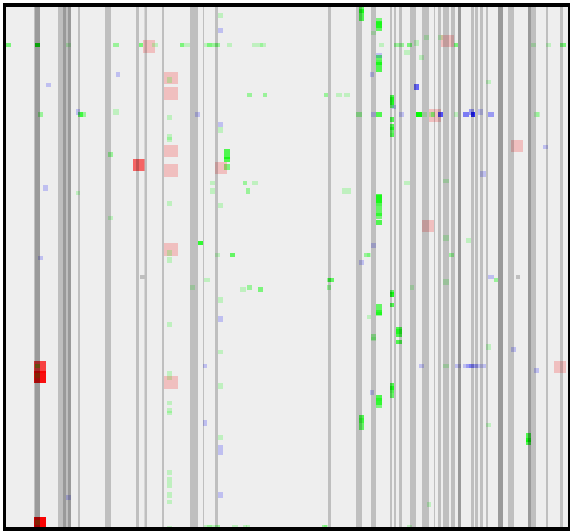
Figure 6: Magnified image of upper left area of Fig.5.